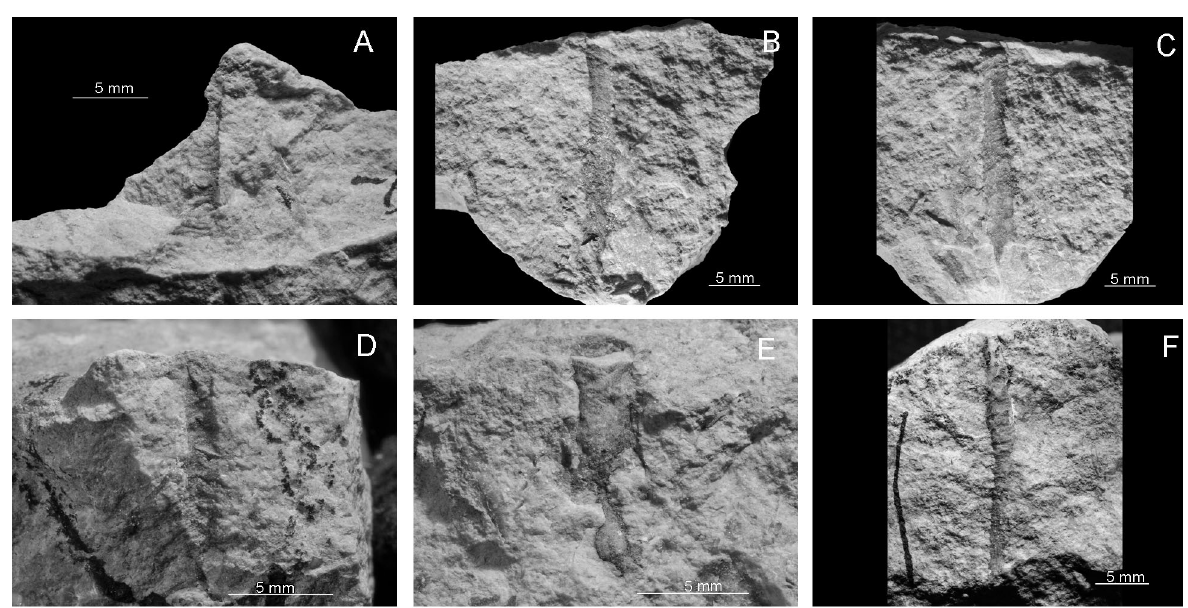
Fig. 2. A (cid:150) F , Oikobesalon coricaceum Phillips, 1848 from the Darriwilian of Osmussaar Island, NW Estonia. A, GIT 697-596-2; B, C, GIT 569-1 part and counterpart; D, GIT 697-338; E, GIT 697-19-2; F, GIT